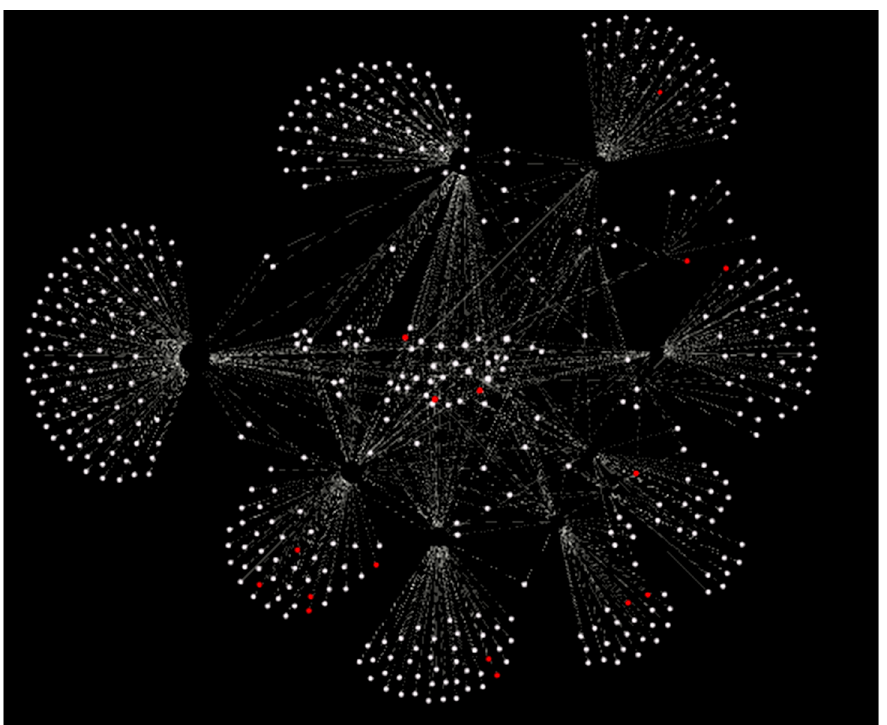
Figure 5. All female gods (in